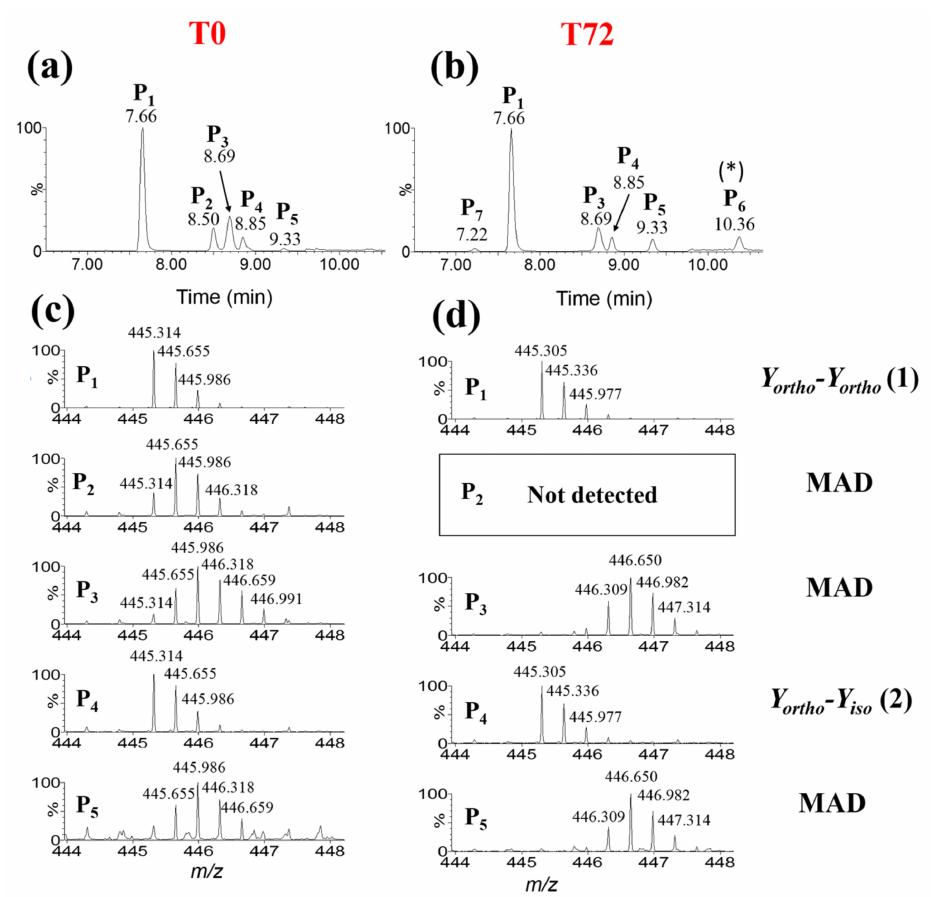
Figure 5. Oxidation of peptide KTSLYG at 40 Gy in the presence of N 3 • . Extracted ion chromatograms m / z 445.31 [M + 3H] 3+ after oxidation in H 2 O at ( a ) T0 (0 h) and ( b ) T72 (72 h). Full scan MS spectra extracted at RT of dimers obtained in D 2 O at ( c ) T0 (0 h) and ( d ) T72 (72 h). (*) P6 intensity was multiplied by a factor of 10. Minor peaks in mass spectra arise from isotopic profiles.